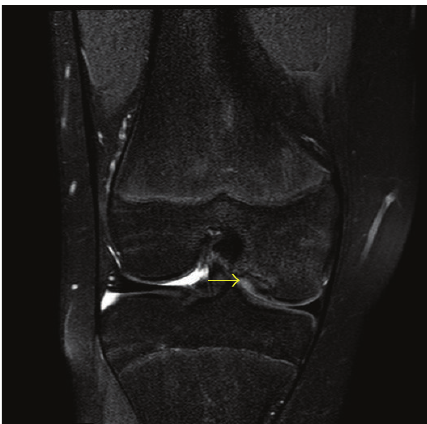
Figure 3: A 13-year-3-month-old female with FOPE zones at both proximal tibiae. Findings: coronal proton density fat-saturated image from follow-up of right knee MRI obtained 6 months after initial MRI shows decrease in the marrow edema surrounding the osteochondral lesion of the medial femoral condyle. The osteo- chondral lesion (arrow) is otherwise unchanged in